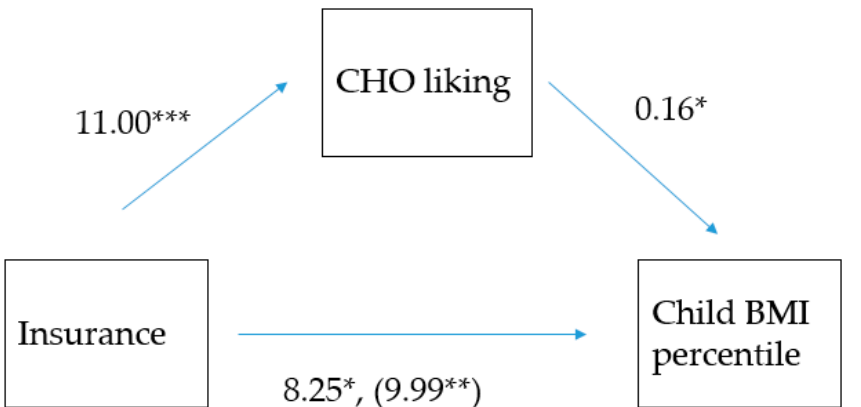
Figure 3. Model of the association between health insurance as a proxy of family income (dichotomous variable, where 1 = private; 2 = public) and the child’s Body Mass Index Percentile (BMI-P), mediated by the parent’s liking of carbohydrate-rich foods among 925 in children seen in an urban pediatric emergency department. * p ≤ 0.05; ** p ≤ 0.01; *** p ≤ 0.005. The (coefficient in the parenthesis) represents the association between insurance and BMI-P before parent liking was added to the model, indicating that parent liking partially mediated the insurance and BMI-P relationship (indirect coefficient = 1.954, p = 0.05).